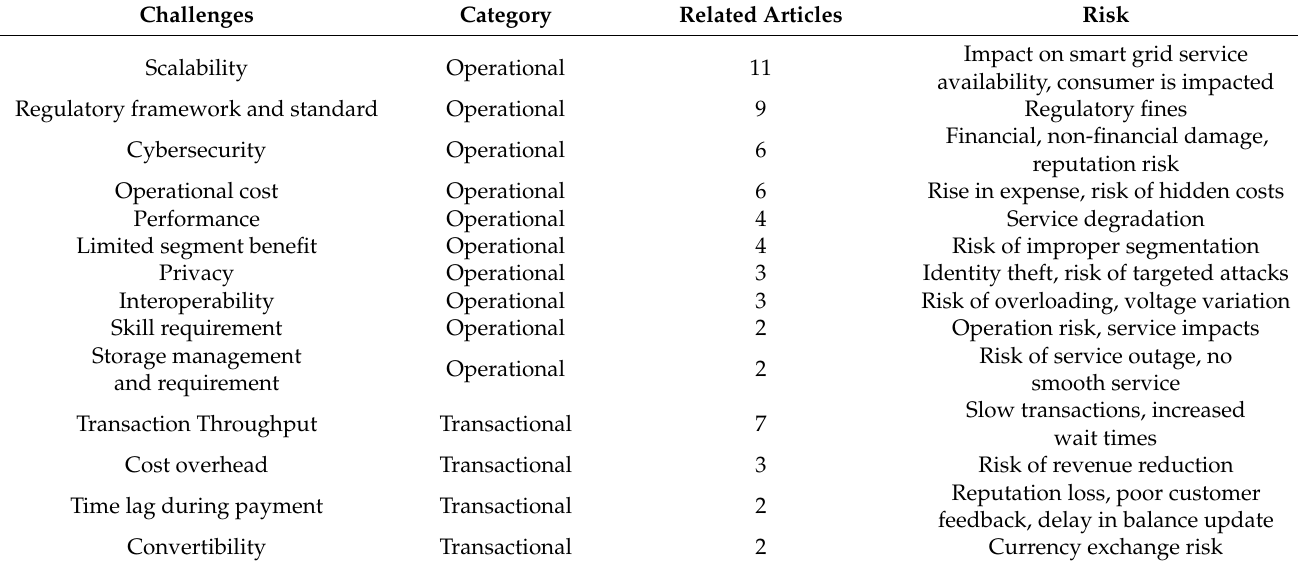
Table 4. Summary of the key